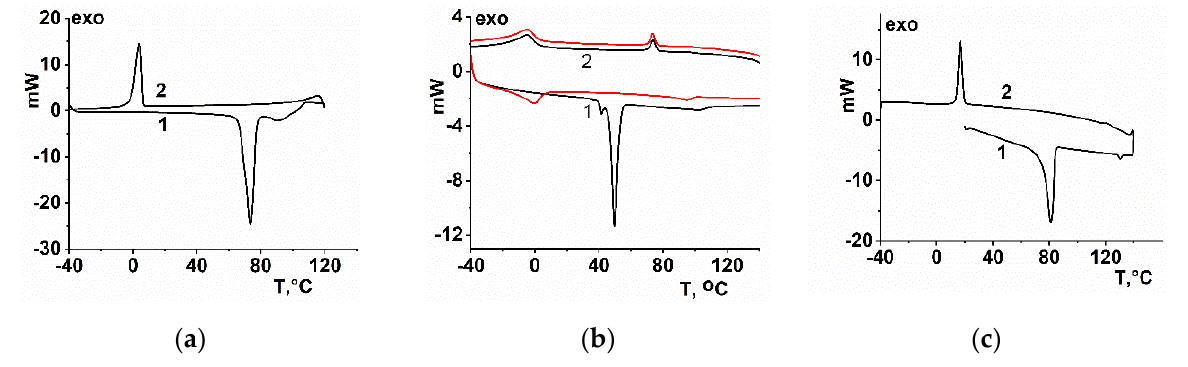
Figure 2. DSC heating (1) and cooling (2) thermograms for mesogens: ( a ) TDOBSН, ( b ) TDOBSNa (1st cycle — black line, 2nd cycle — red line), ( c ) TDOBSPyr. Exo peaks are positive. Scanning rate 5 °C/min. Table 1. Thermal parameters of TDOB, TDOBS Н , TDOBSNa and TDOBSPyr measured by